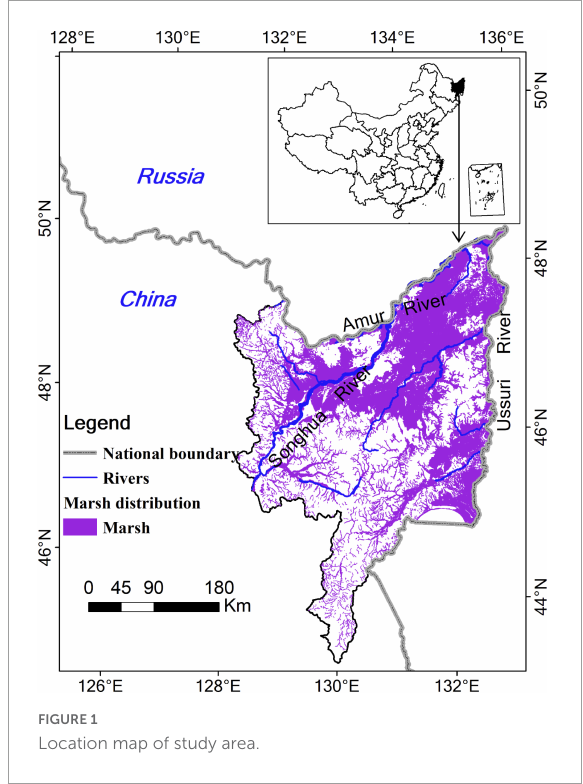
FIGURE1 Location map of study